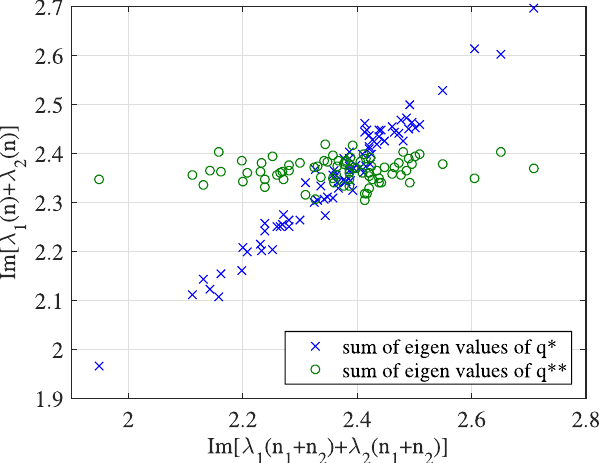
Figure 11. Noise decomposition for 2-soliton with discrete eigenvalues 0.9 j and 1.5 j